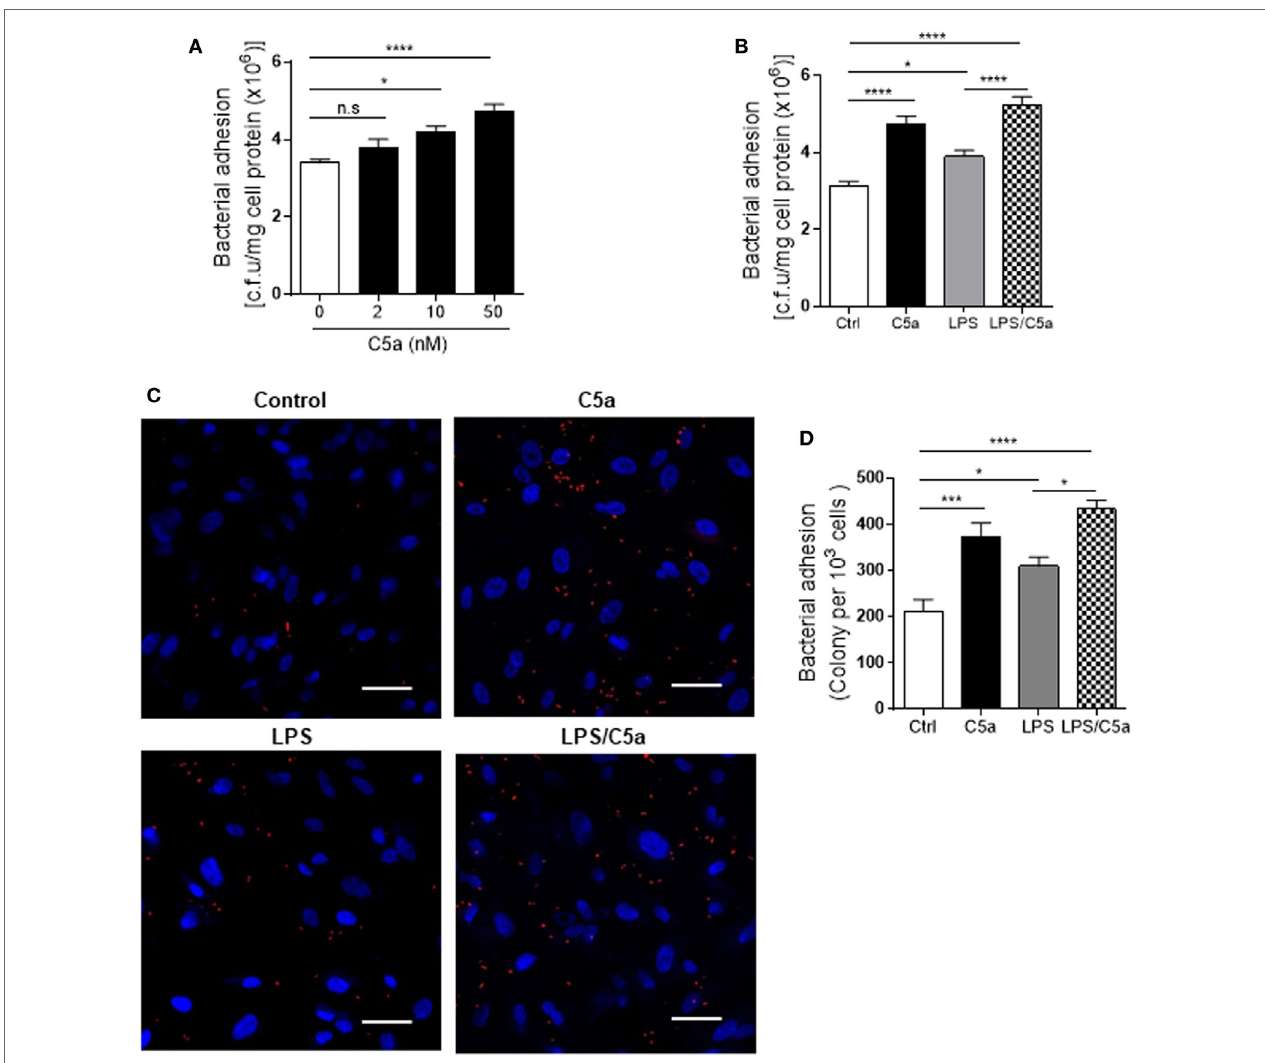
FigUre 1 | Effect of C5a stimulating renal tubular epithelial cell (RTEC) on bacterial adhesion to the RTEC. RTEC were pre-treated with C5a (as indicated or otherwise 10 nM) and/or LPS (800 ng/mL) for 24 h and subjected to assessment of bacteria binding to RTEC. (a,B) Bacterial adhesion to RTEC, evaluated by bacterial plate count assay. (c,D) Bacterial adhesion to RTEC, evaluated by fluorescence microscopy analysis. (c) Representative fluorescence images of tri-iodothyronine and tetramethylrhodamine-labeled J96 adhesion to RTEC, J96 (red), and 4’,6-diamidino-2-phenylindole (blue). Scale bars, 50 µm. (D) Quantification of bacteria adhesion to RTEC corresponding to the images in (c) . Results were expressed as number of bacteria per 10 3 RTEC. (a,B,D) data were analyzed by one-way ANOVA with Tukey’s multiple comparisons test [ (a) n = 12 individual wells per group, (B) n = 8 individual wells per group, (c) n = 6 individual images ( × 200 magnification) from two coverslips per group]. All results shown are representative of three independent experiments. * P < 0.05, *** P < 0.001, **** P <